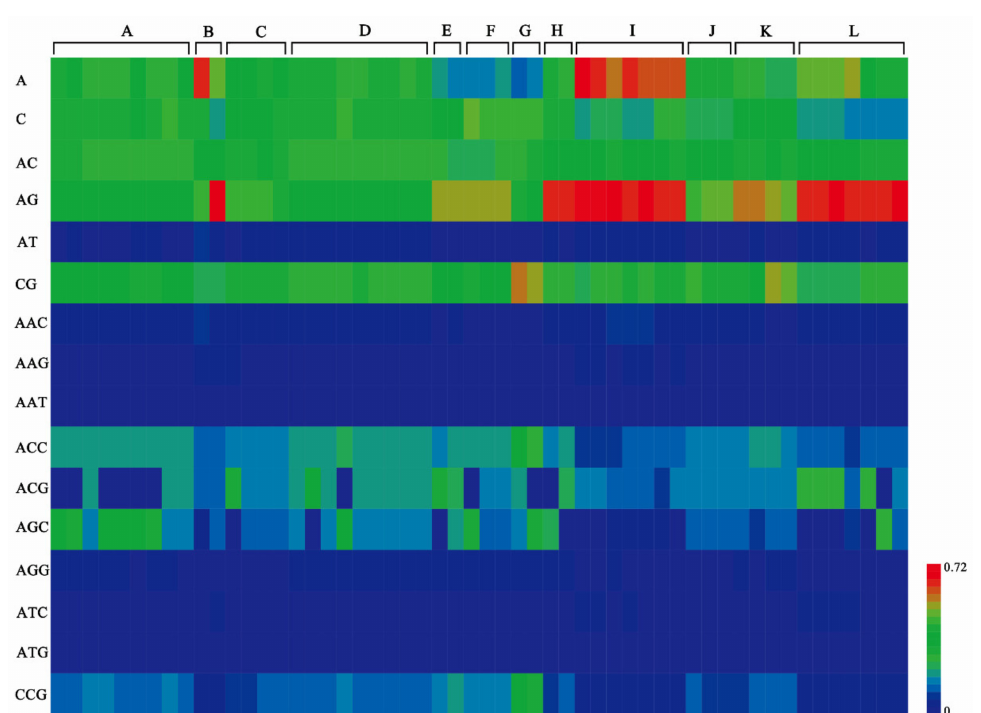
Figure 5. Relative abundance of standard motifs in mononucleotide, dinucleotide, and trinucleotide repeat type identified in genomes of 54 Parasynechococcus -like strains. The relative abundance of each motif was represented by a color block, whose color was proportional to the values (/kb) as indicated by the scale bar. Each vertical bar represented the motifs from one genome, and genomes were grouped by the subclades (A–L) identified in Figure 1b. Heatmap was generated using the gplots package in R